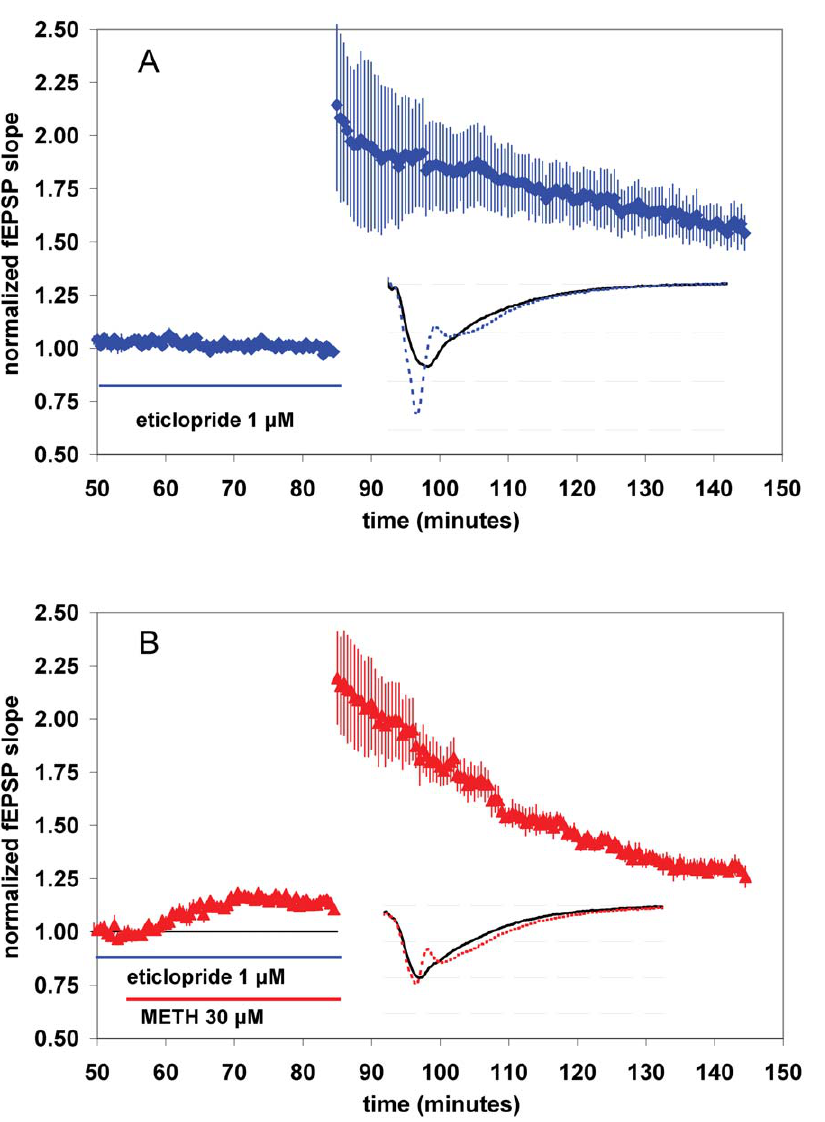
Figure 3. The effects of METH on baseline synaptic transmission and LTP are not altered by pre-application eticlopride (a selective D2-like dopamine receptor antagonist). ( A,B ) Summary plot of normalized fEPSP slope measurements recorded in the CA1 region of the hippocampus. The red triangles (B) are from eticlopride (1 m M) and METH (30 m M) treated slices; the blue diamonds (A) show results from eticlopride (1 m M) experiments. Error bars are 6 SEM. Insets are 30-msec sweeps taken from representative experiments illustrating the average fEPSP 0–5 min prior to (solid line) and 55–60 min post-tetanus (dotted line, horizontal dashed lines are 1 mV apart).